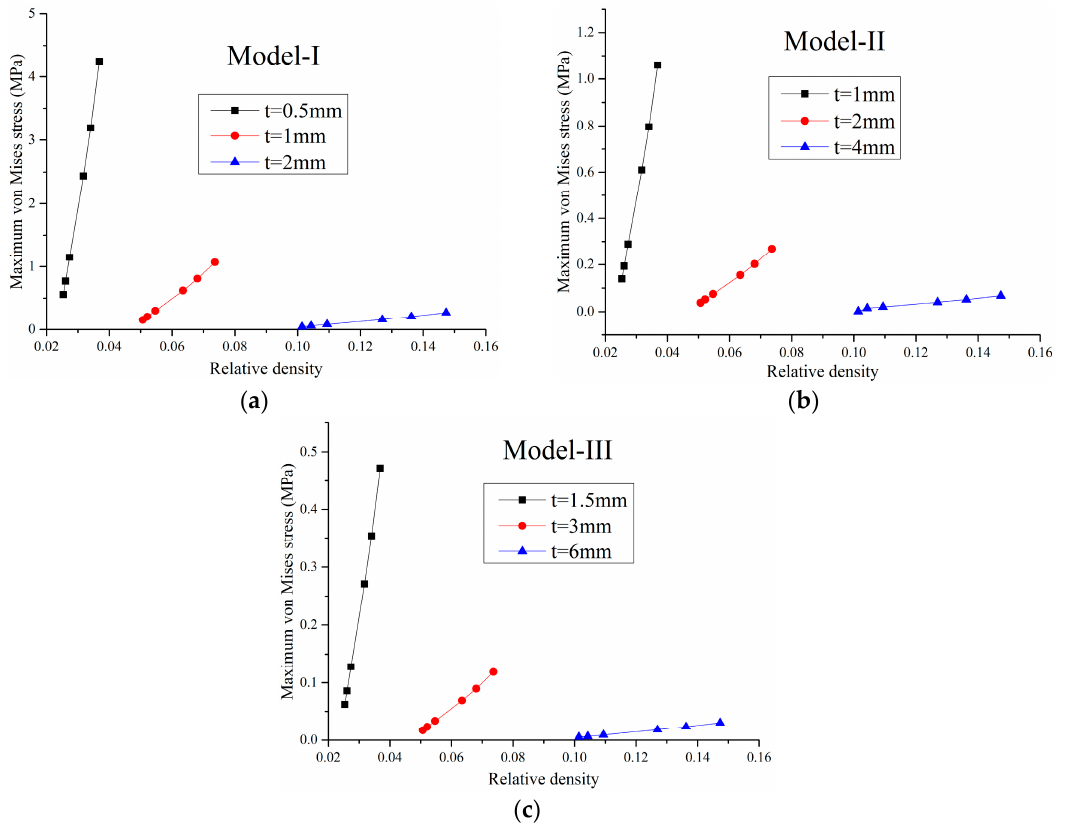
Figure 6. Maximum von Mises stress versus the relative density: ( a ) Model-I; ( b ) Model-II and ( c ) Model-III.